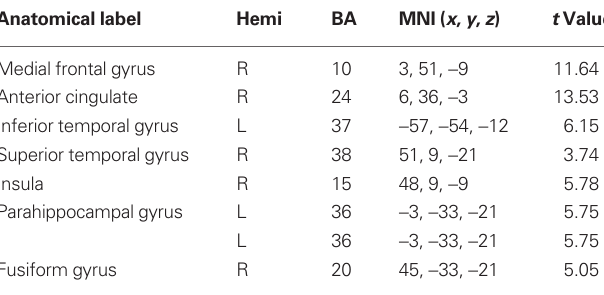
Table 7 | fMRI peak values for RSN 6 self-referential